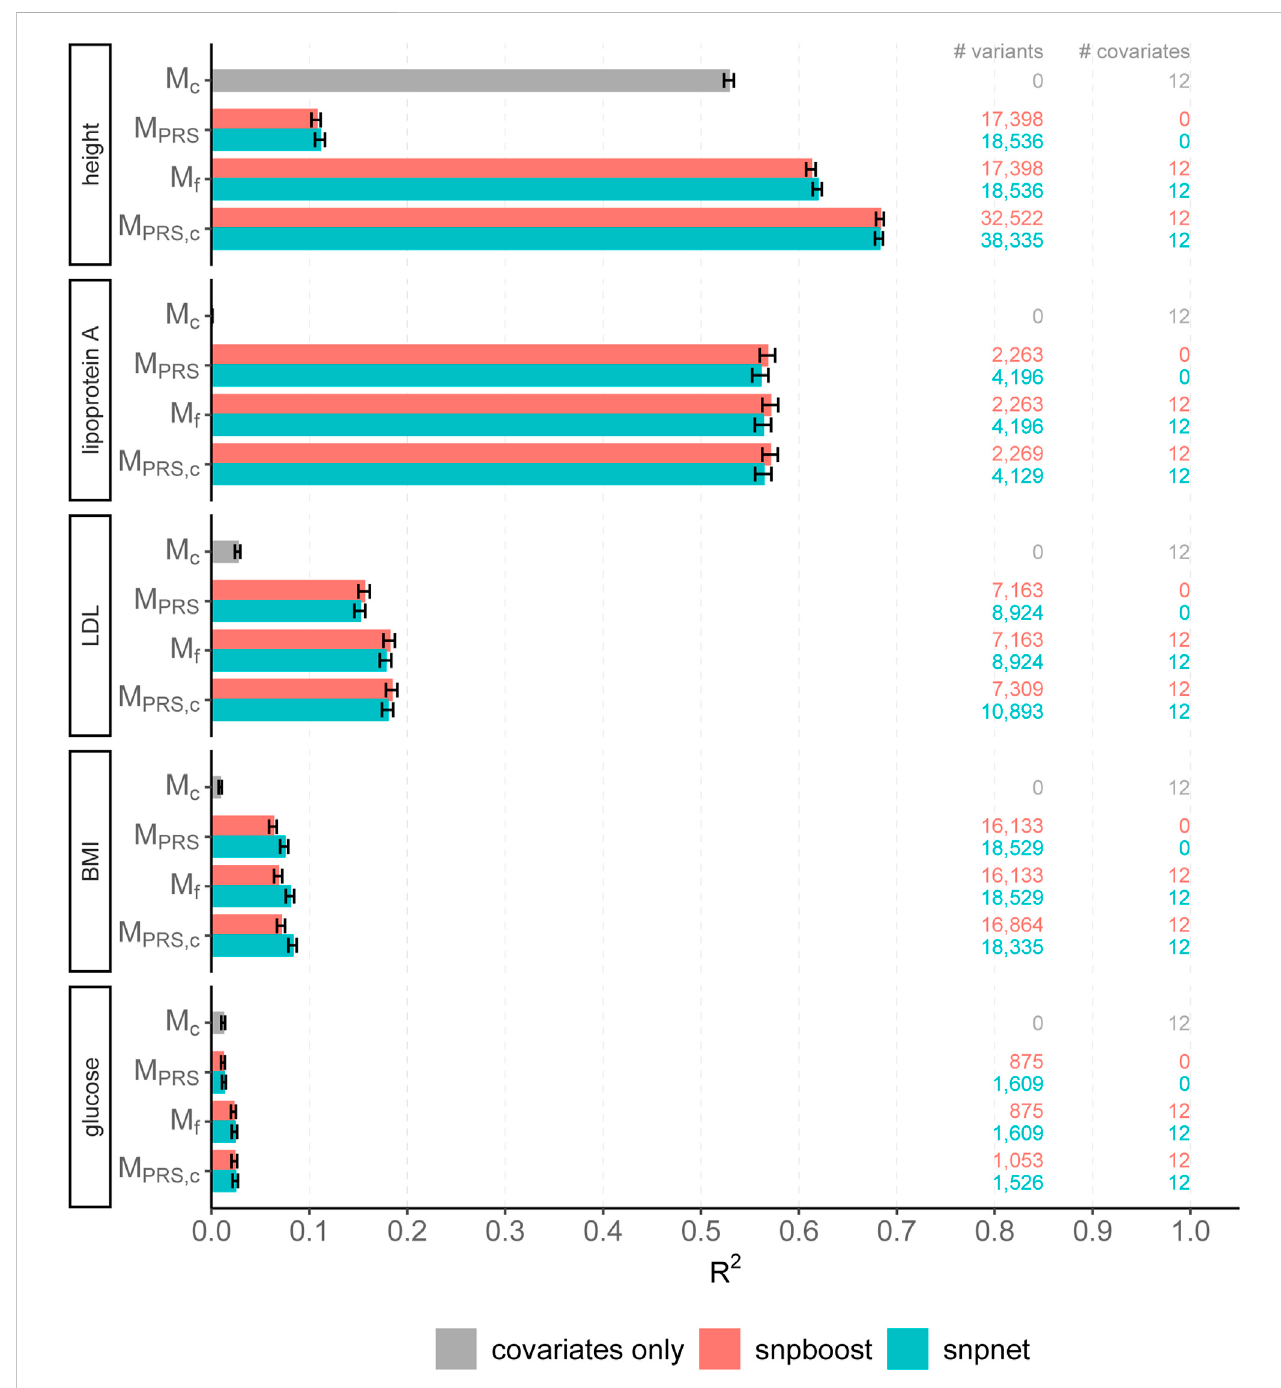
FIGURE 5 Comparison ofpredictiveperformanceofsnpnetandsnpboostfor fi vecontinuousphenotypesfromtheUKBB. Resultsofthecovariate-onlymodel( M c ; grey bars) and multivariable polygenic models with and without inclusion of the covariates derived by lasso (snpnet; petrol-colored bars) and statistical boosting (snpboost; red bars) for the prediction of fi ve phenotypes from the UKBB. The barplots show the predictive performance ( R 2 ) on the test set of 52,551unrelatedwhiteBritishindividuals. M PRS correspondstoalinearmodelincorporatingthePRSasasinglepredictorvariableand M f toalinearmodel incorporation sex, age and the fi rst ten principal components as additional covariates. M PRS, c includes the covariates already in the fi tting process of the PRS. Bootstrapped 95% con fi dence intervals are indicated by error bars. Furthermore, information on the number of selected genetic variants (# variants) and the number of additionally included covariates (# covariates) is